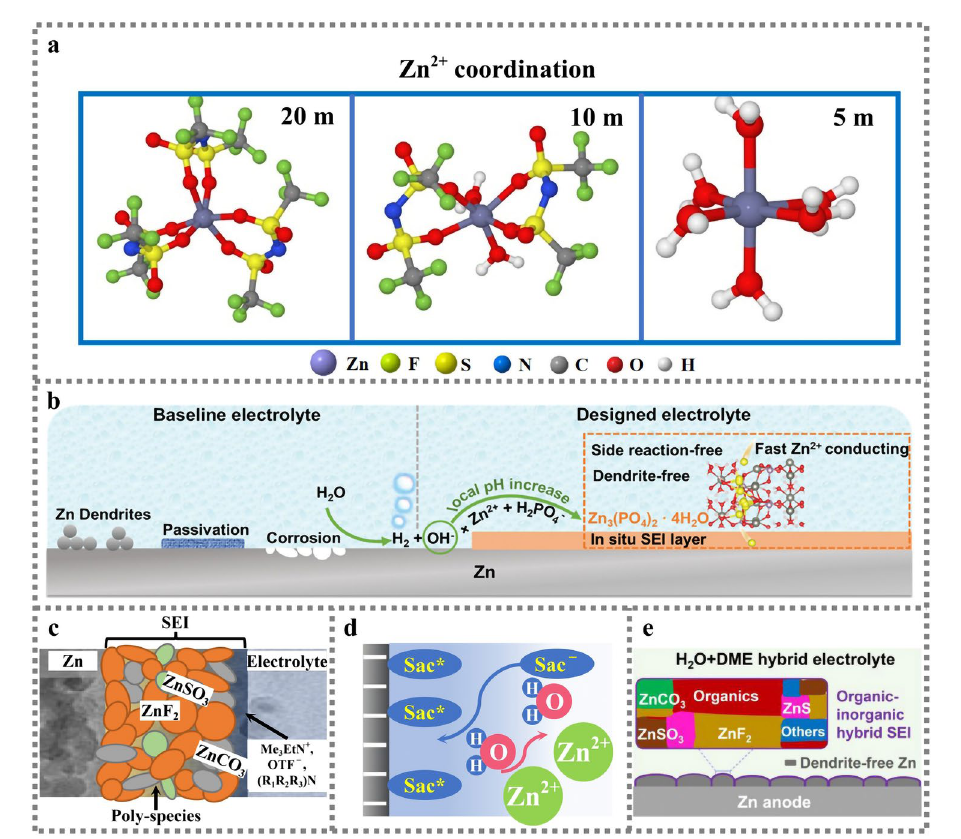
Fig. 8 a Solvation structure of Zn ions in electrolytes with different concentrations [35]; Copyright 2018, Springer Nature. b Schematic illustra- tion of Zn surface evolution and the SEI formation mechanism [38]; Copyright 2021, Wiley–VCH. c Schematic diagram of proposed Zn 2+ con- ducting SEI [39]; Copyright 2021, Springer Nature. d The schematic descriptions of EDL structure after introducing Sac (Sac − represents free Sac anions, Sac* represents the Sac anions chemically bonded with Zn surface) [40]; Copyright 2021, Wiley–VCH. e Schematic illustration of the interphase chemistry on Zn electrode [87]. Copyright 2022,